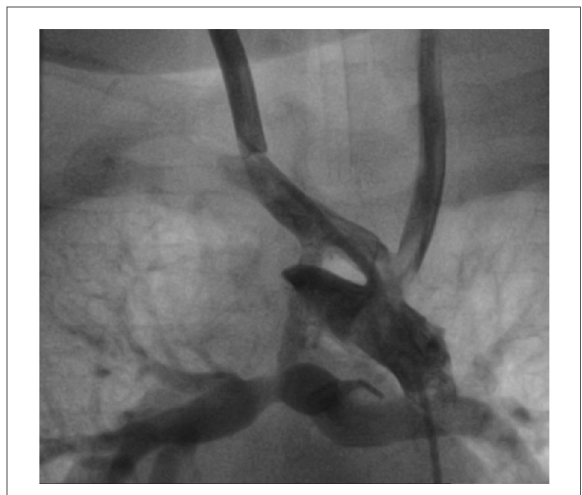
FIGURE 3 Hypoplastic diffusion BT shunt (2 mm) without signi fi cant stenosis. After guide placement, multiple dilations with 3/3.5/4 mm balloons are performed. The control BT shunt size was 4 mm.